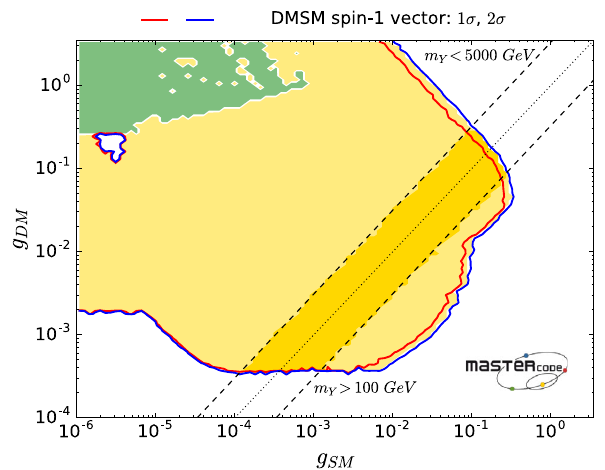
Fig. 5 Preferred regions in the ( g SM , g DM ) plane (on logarithmic scales) in the vector-like model, where we have marginalized over the masses, m χ and m Y . We again use colour coding to illustrate the domi- nantmechanismsbringingtheDMdensityintotheallowedrange:green for annihilation via t -channel exchange into pairs of mediator particles Y that subsequently decay into SM particles, and yellow for rapid anni- hilation directly into SM particles via the s -channel Y resonance. The diagonal dotted line indicates where g DM = g SM , and the band where 1 / 3 < g DM / gsm < 3 is bounded by dashed lines and shaded a darker yellow g SM (cid:3) 0 . 3, nor that for g DM , which is also featureless apart from a steep rise for g DM (cid:2) 3 × 10 − 4 that is an artefact of the limit on our scanning range for m Y